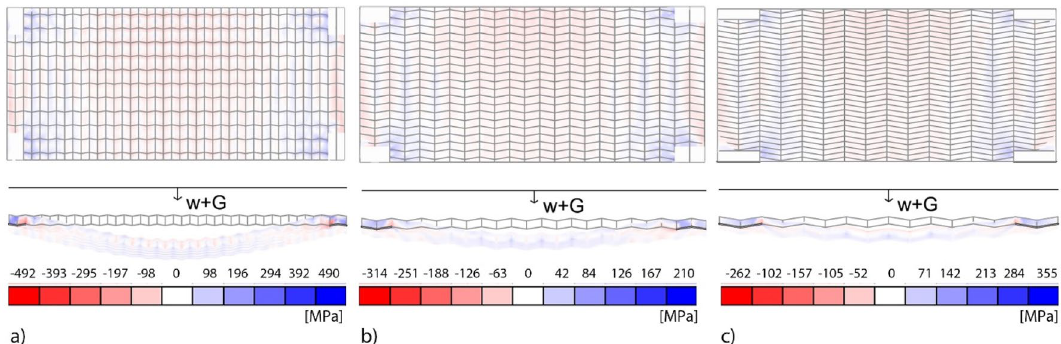
Figure 14. Von Mises stress distribution for Δy/Δx = 0.6 ( a ), Δy/Δx = 2.0 ( b ) and Δy/Δx = 4.0 ( c ). Blue represents tension and red